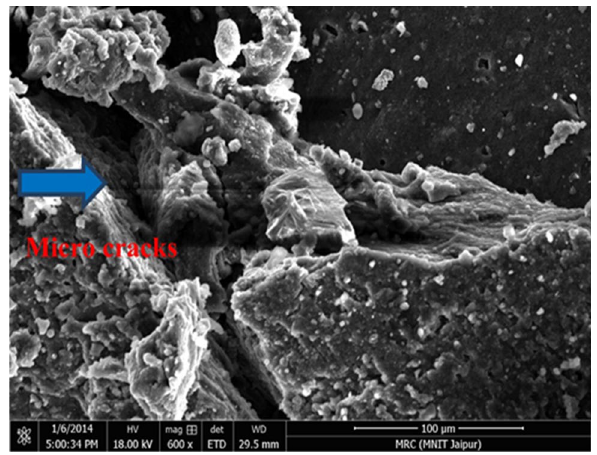
Fig. 21 SEM image of rubber fiber at 600 × magnification